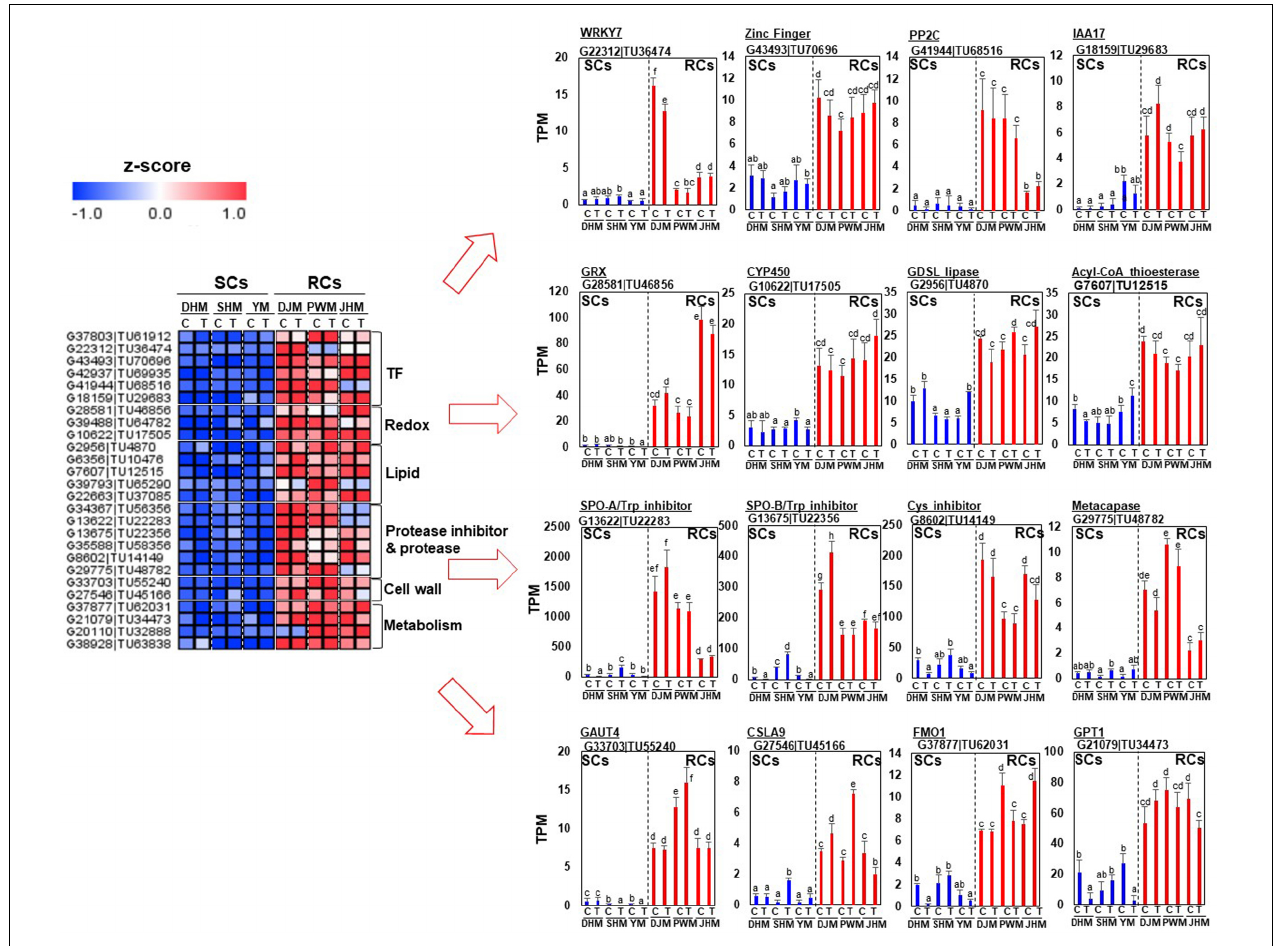
FIGURE 7 | Comparison of the expression levels of RC-specific candidate genes in six sweetpotato cultivars under control and RKN-infected conditions. DEGs related to transcription factors, redox regulation, lipid, cell wall, metabolism, protease and protease inhibitors were identified. The heatmap was constructed using Multi Experiment Viewer (MeV). DHM, Dahomi; DJM, Danjami; PWM, Pungwonmi; SHM, Shinhwangmi; JHM, Juhwangmi; YM, Yulmi; RCs, resistant cultivars; SCs, sensitive cultivars; C, control; T, treatment. Bars denoted with the same letter are not significantly different ( P = 0.05) according to Dunnett’s